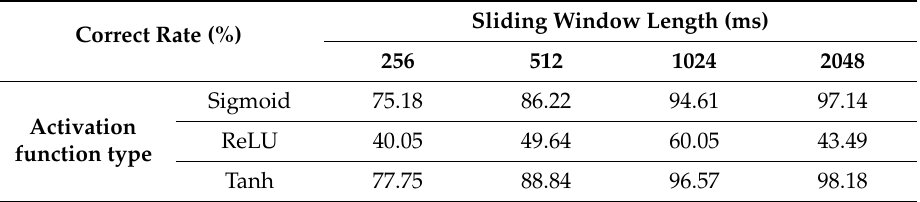
Table 4. Recognition accuracy of the LSTM model with di ff erent activation functions and di ff erent sliding window lengths. ReLU: rectified linear